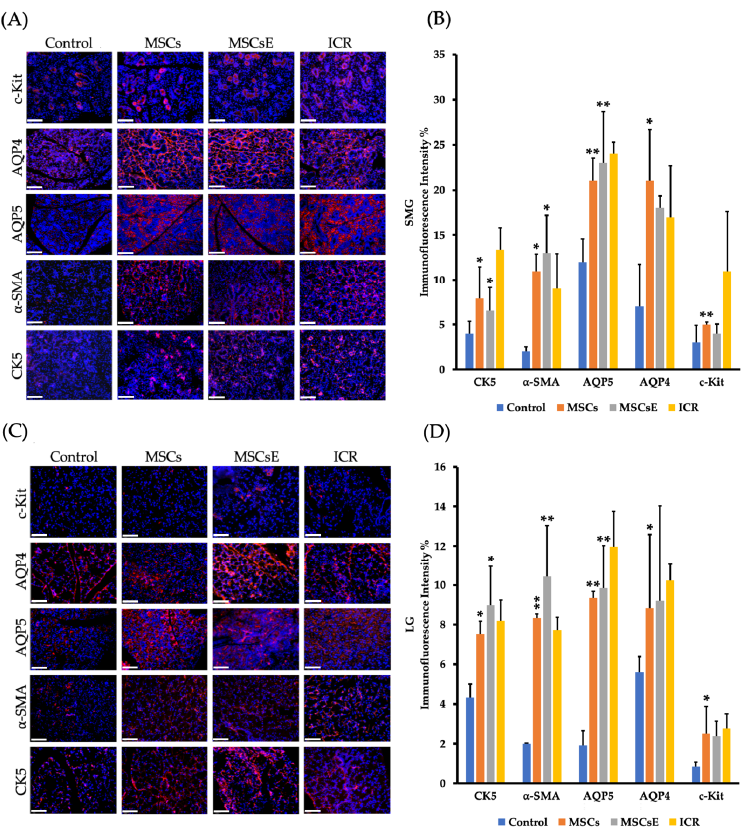
We apologize for any inconvenience brought to the readers. 17 Figure 2. Special cell subpopulations in submandibular (SMG) and lacrimal glands (LG) were evaluated by immunofluorescence staining at 16 weeks post-treatment. ( A , C ) SMG / LG immunofluorescence staining, respectively, positive for AQP5 (marker for water channel protein expressed by acinar cells in SMG and acinar / ductal cells in LG), α -SMA (marker for myoepithelial cells), AQP4 (marker for acinar and ductal cells), CK5 (marker for ductal / progenitor cells), and c-Kit (marker for stem / progenitor cells) were tested in frozen sections, scale bar = 148 µ m. (B , D ) Quantification of protein immunofluorescence expression levels in submandibular / lacrimal glands, respectively, from 4–6 random fields / glands by Image J software. MSCs- / MSCsE-treated groups showed higher intensities for all the tested markers when compared with the control group. All images were randomly taken at 200 × magnification. *